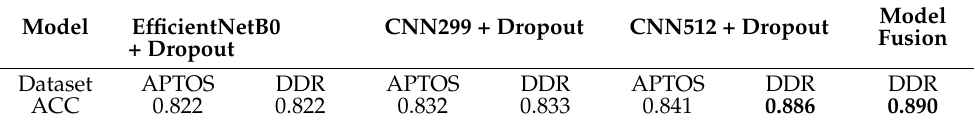
Table 18. The performance comparison among all of the